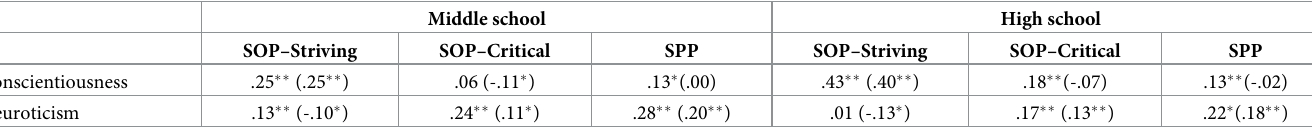
Table 4. Correlations between the CAPS-14 scales and personality